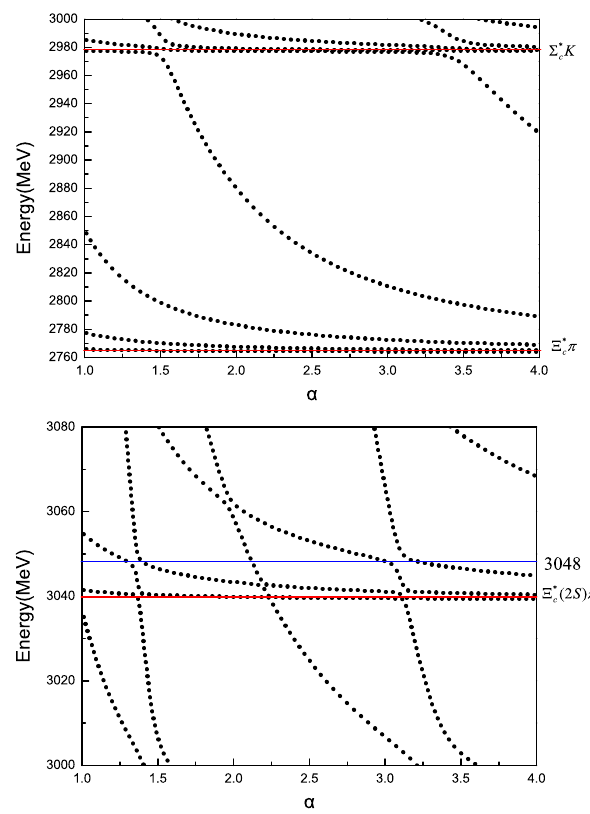
− 1 system Fig. 3 Energy spectrum of 1 2 2